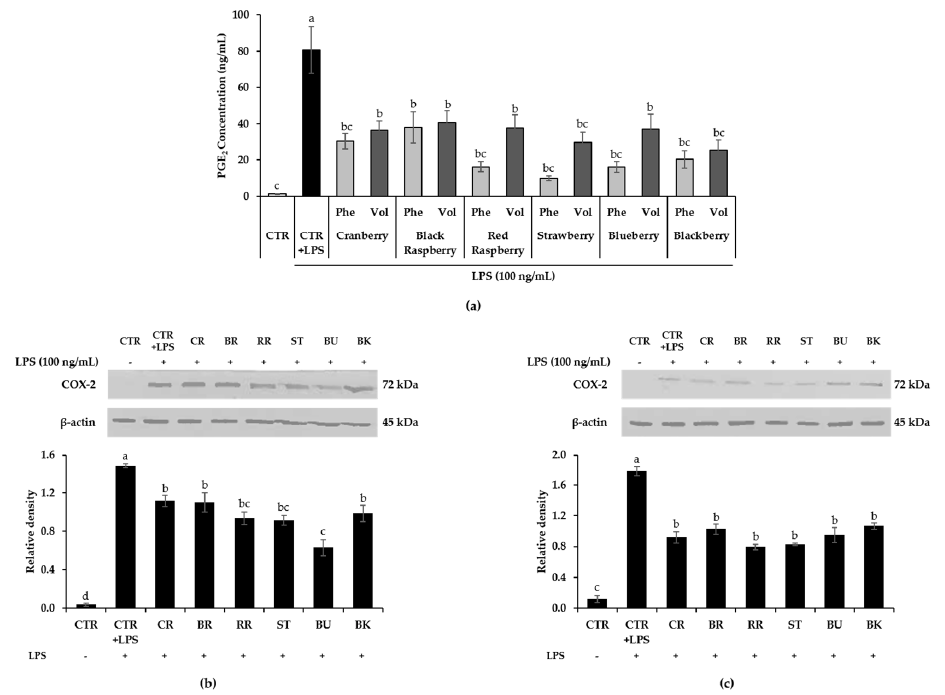
Figure 3. ( a ) E ff ect of berry phenolic and volatile extracts (50-fold dilution) on LPS-induced PGE 2 production in RAW264.7 macrophages. Effect of ( b ) berry phenolics and ( c ) berry volatiles